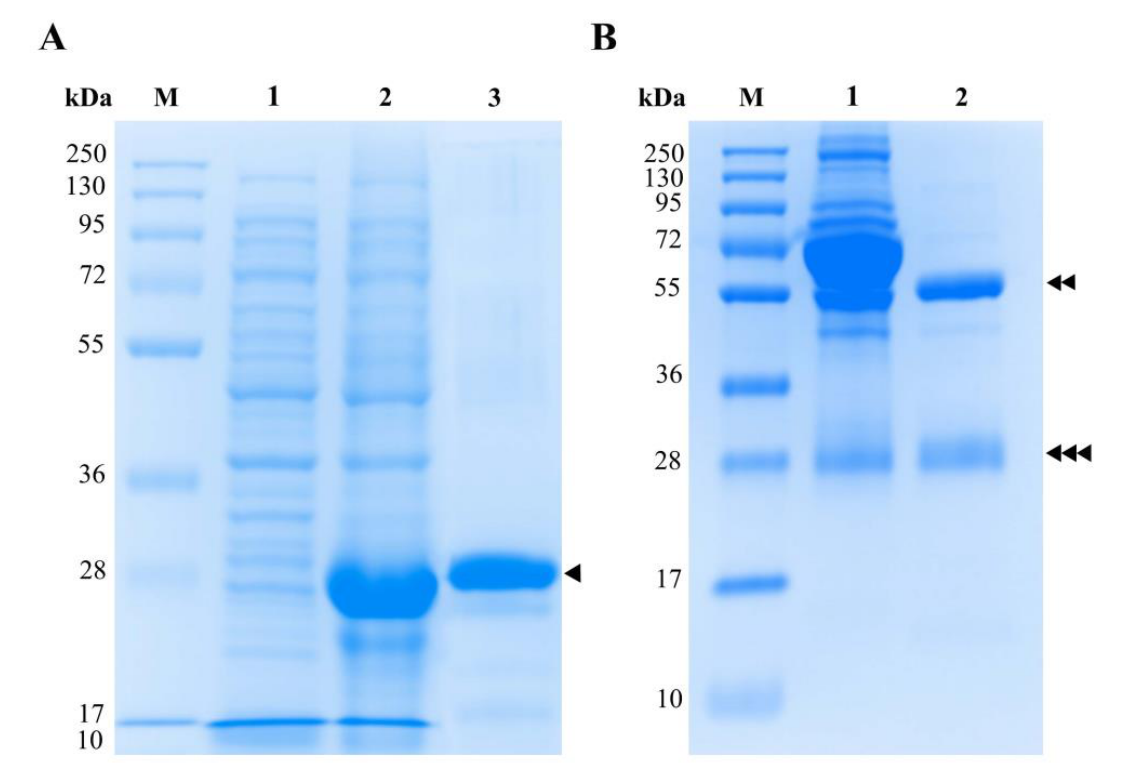
Figure 2. The 12.5% SDS-PAGE analysis of rFgCathL1H expression ( A ) and purified rabbit anti-rFgCathL1H ( B ), followed by Coomassie brilliant blue staining. M is a molecular size protein marker. In Figure 2A, lane 1 is non-induction, lane 2 is the induction with IPTG, and the purifica- tion of rFgCathL1H in lane 3 is approximately 28 kDa (single-head arrow). In Figure 2B, lane 1 is rabbit anti-rFgCathL1H serum (containing all serum proteins including PoAb anti-rFgCathL1H). Lane 2 is the purified IgG of rabbit anti-rFgCathL1H using Protein G. The expected molecular weight of heavy chain and light chain at 55 kDa and 25 kDa, as shown by the double-head arrow and triple-head arrow, respectively.